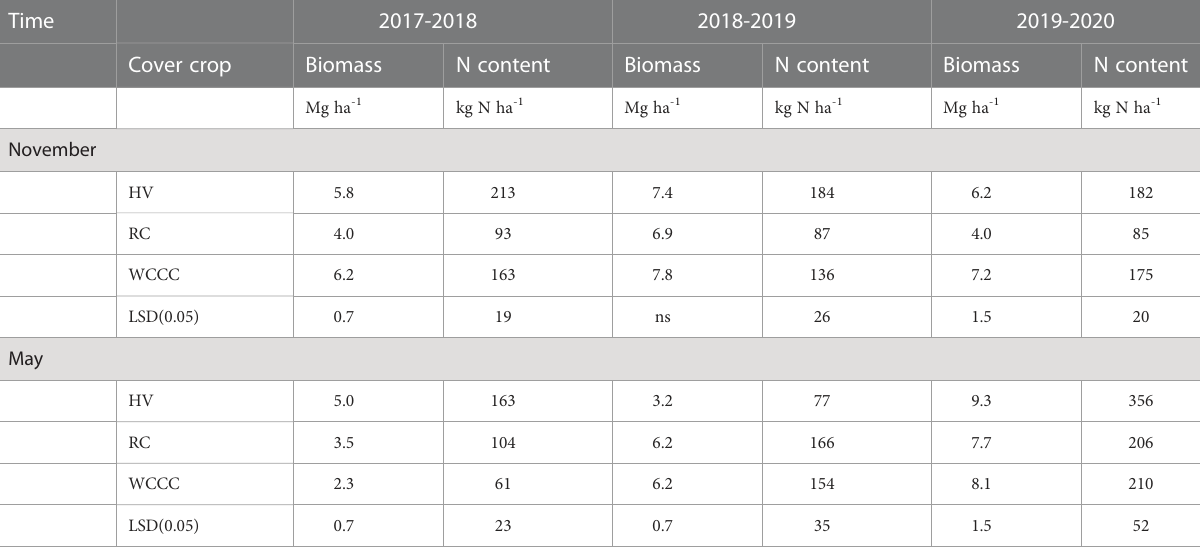
TABLE 2 Above-ground crop biomass and biomass nitrogen (N) in cover crop (HV, RC, WCCC) in November 2017, 2018 and 2019 shortly before cover crop termination by moldboard plow-down (CT treatment), and in May 2018, 2019 and 2020 shortly before cover crop termination by herbicide spray-down (NT and ST